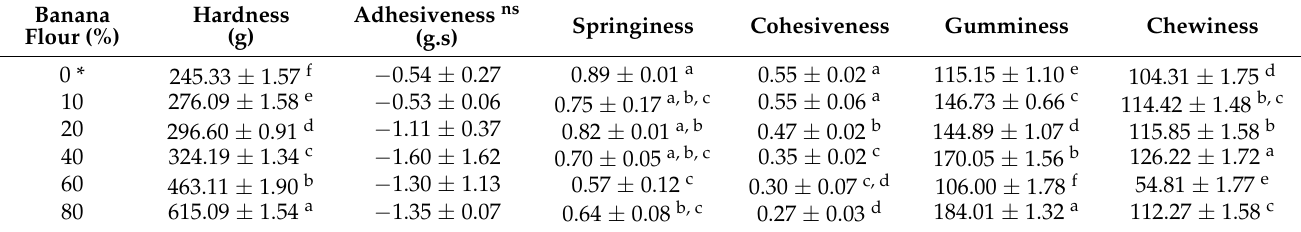
Table 4. Texture profile analysis of breads made with different amounts of unripe banana